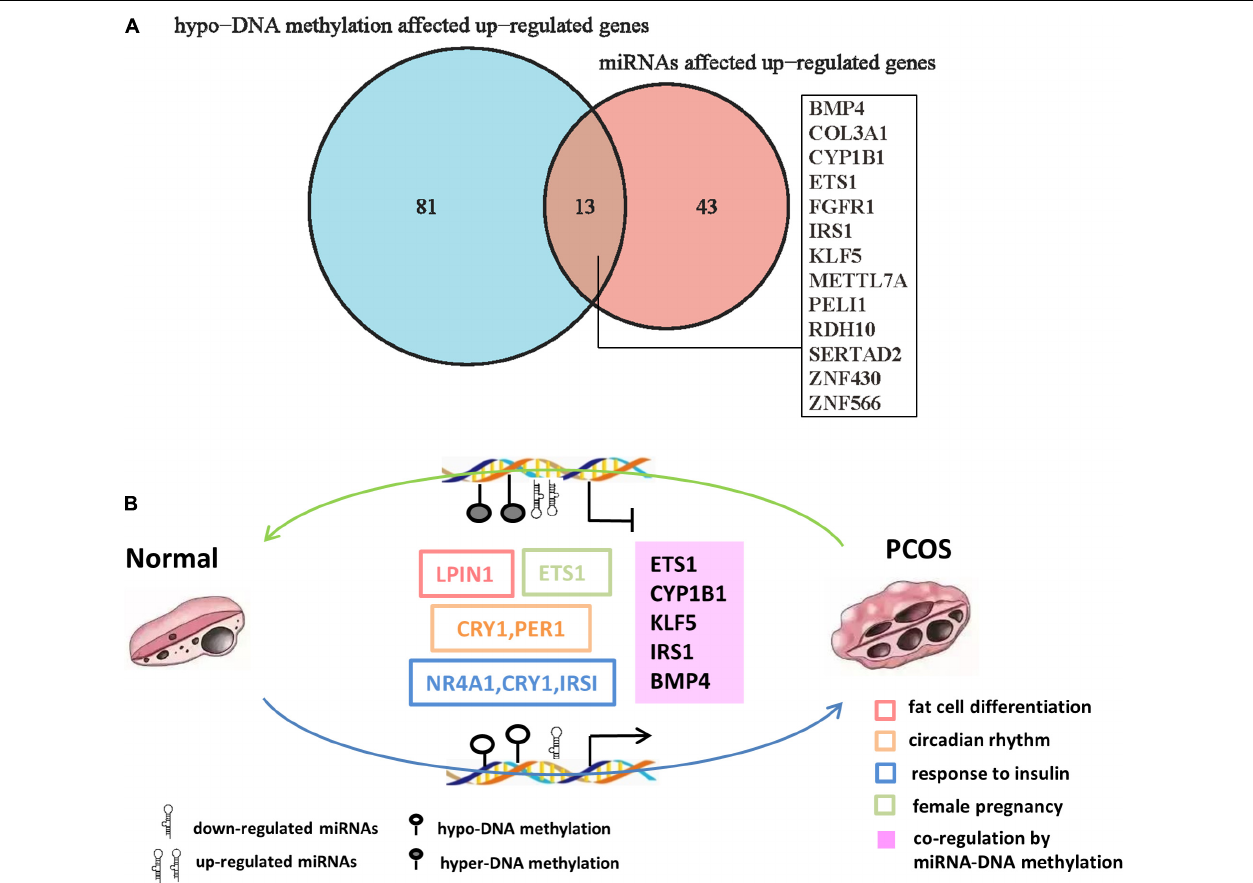
FIGURE 6 | The DNA methylation and miRNA coregulation profile in PCOS. (A) Venn diagram showing the genes that are coregulated by downregulated miRNAs and reduced DNA methylation in PCOS. (B) Coregulation of DNA methylation and miRNA in PCOS. The key molecular markers and pathways are labeled in different colors. The hollow box represents the signaling pathway where the marker genes are involved, and the solid box represents the genes that are coregulated by miRNA and DNA